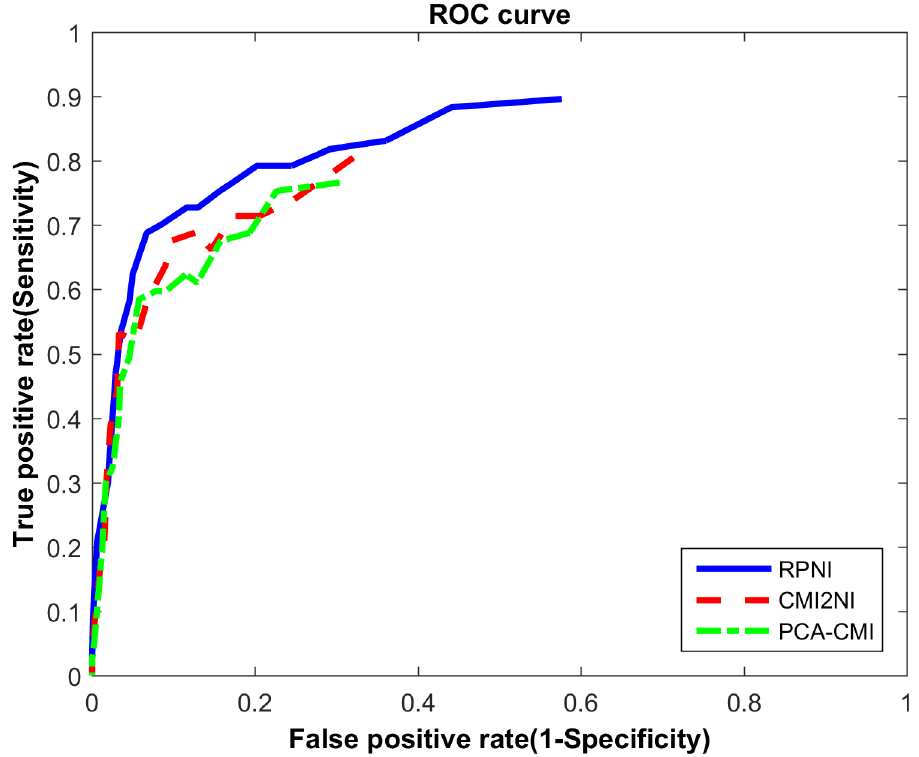
Fig 4. ROC curves of several methods on DREAM3 challenge Yeast1 dataset in size